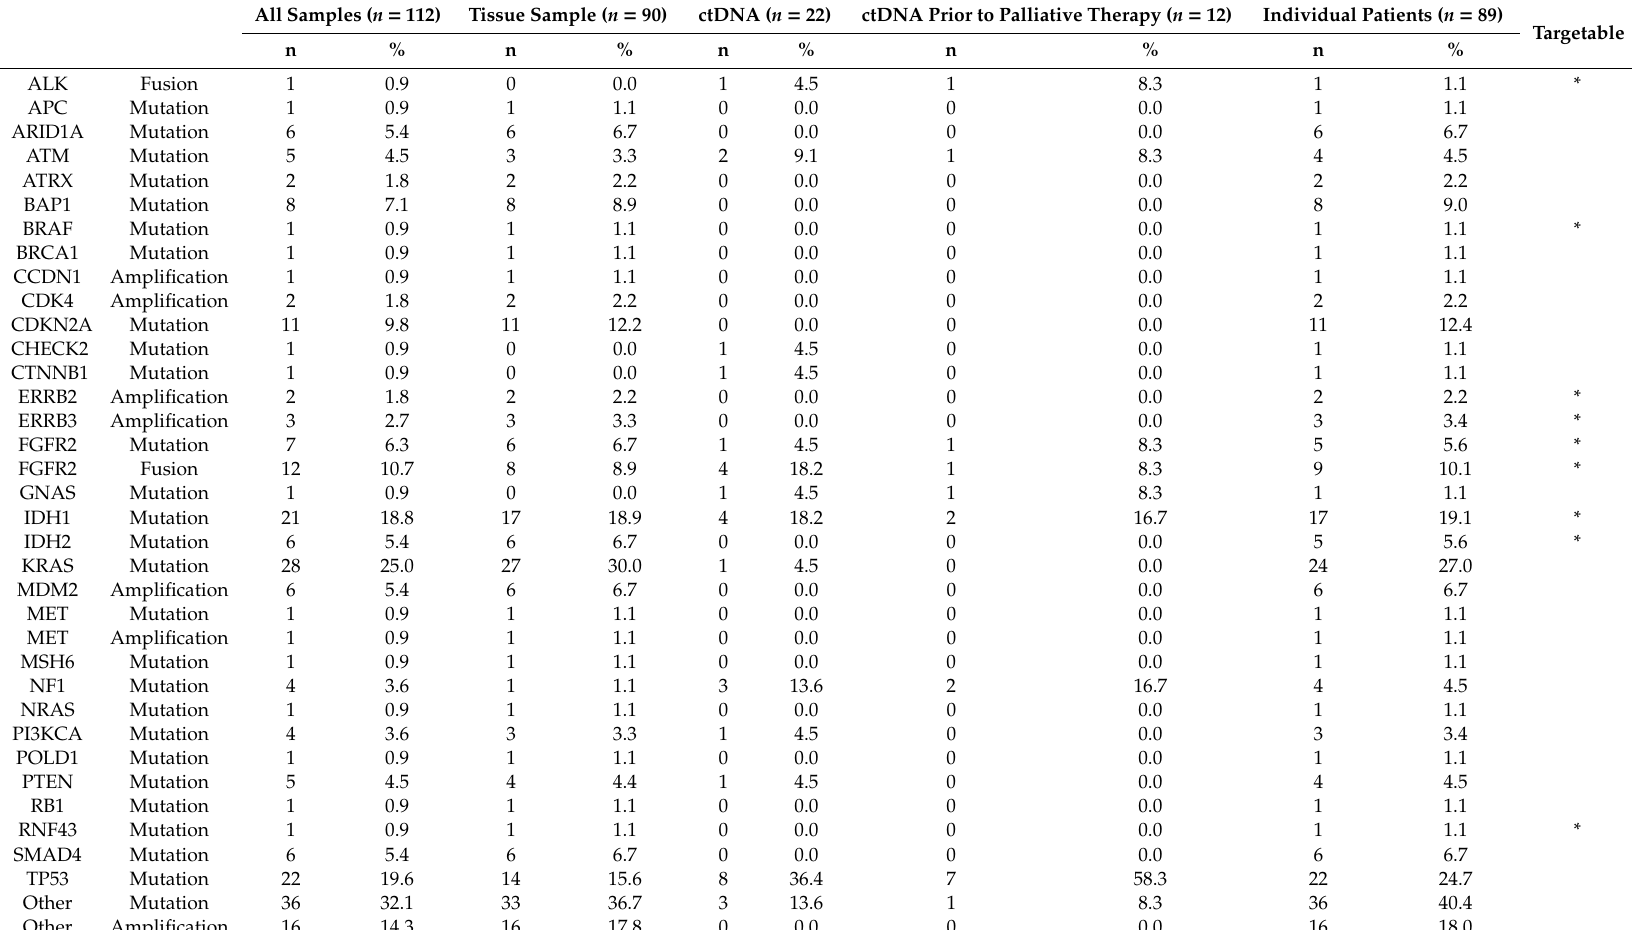
Table 3. Summary of pathological molecular findings by sample